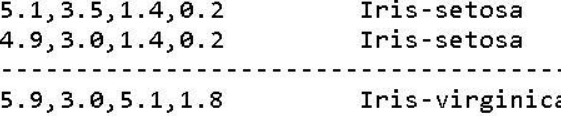
Figure 1. Examples of patterns included in the iris.data file. However, the algorithmic steps of the linear associator require column patterns, both for simply taken and converted into a column pattern as in Equation (15), thus avoiding unnecessary excess